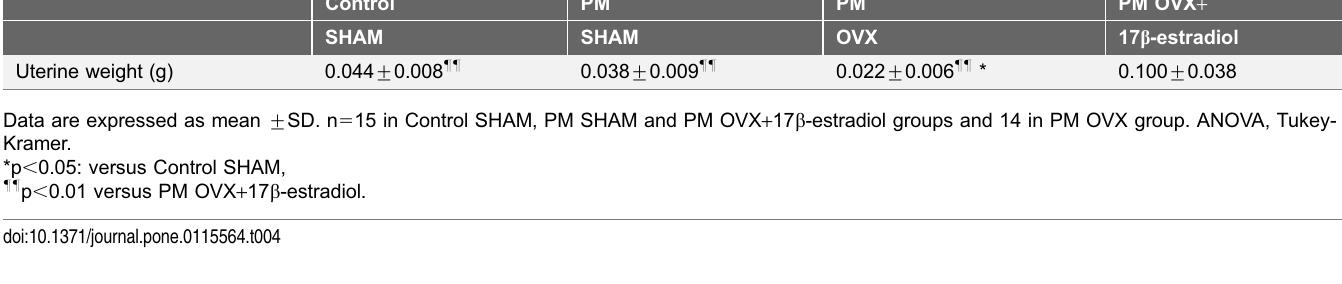
Table 4. Uterine weight among the four groups.